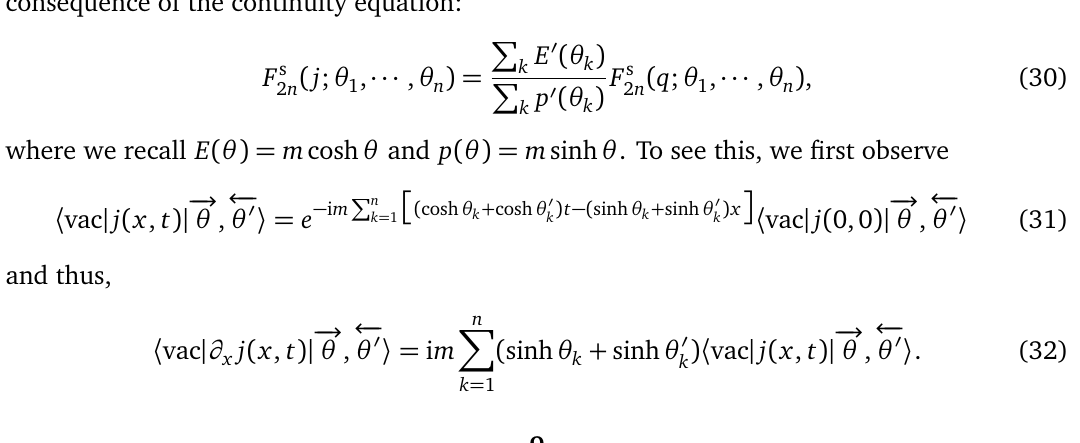
Figure 3: Pictorial representation of one of terms in the RHS of (13). Each term (forest) of L ( α | α ) and each term in F c together at vertices α represented by black